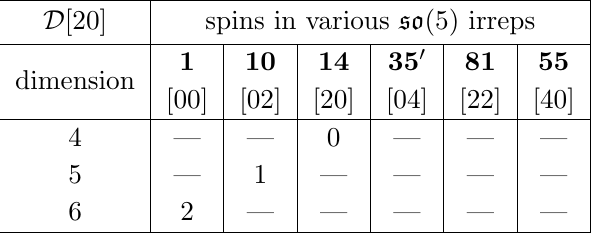
Table 3 . All possible conformal primaries in D [20] (cid:2) D [20] corresponding to the D [20] supercon- formal multiplet.